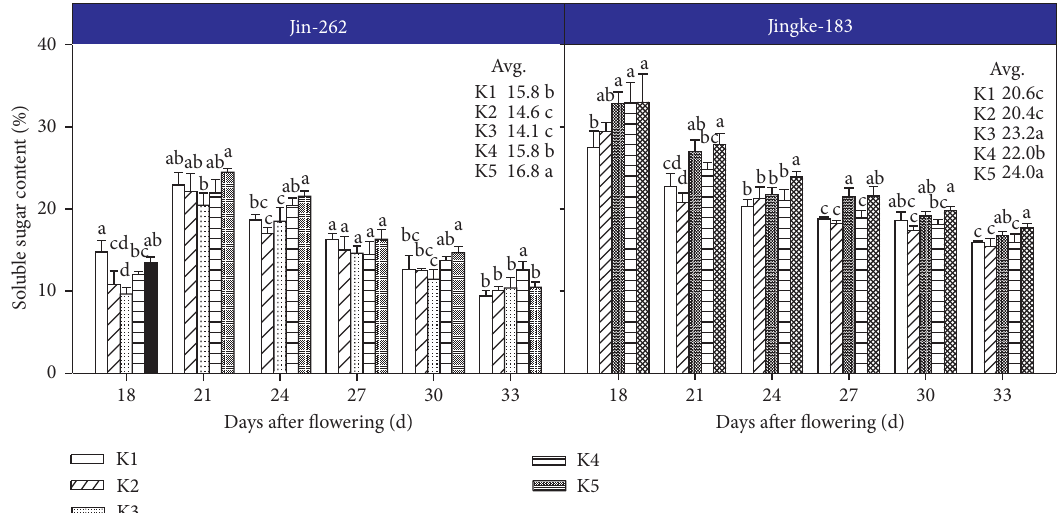
Figure 2: Effects of potassium on the grain soluble sugar content of fresh-eaten maize grains. The different lowercase letters are significant differences at the 5% level; AVG, average; the bars are standard deviation ( n �